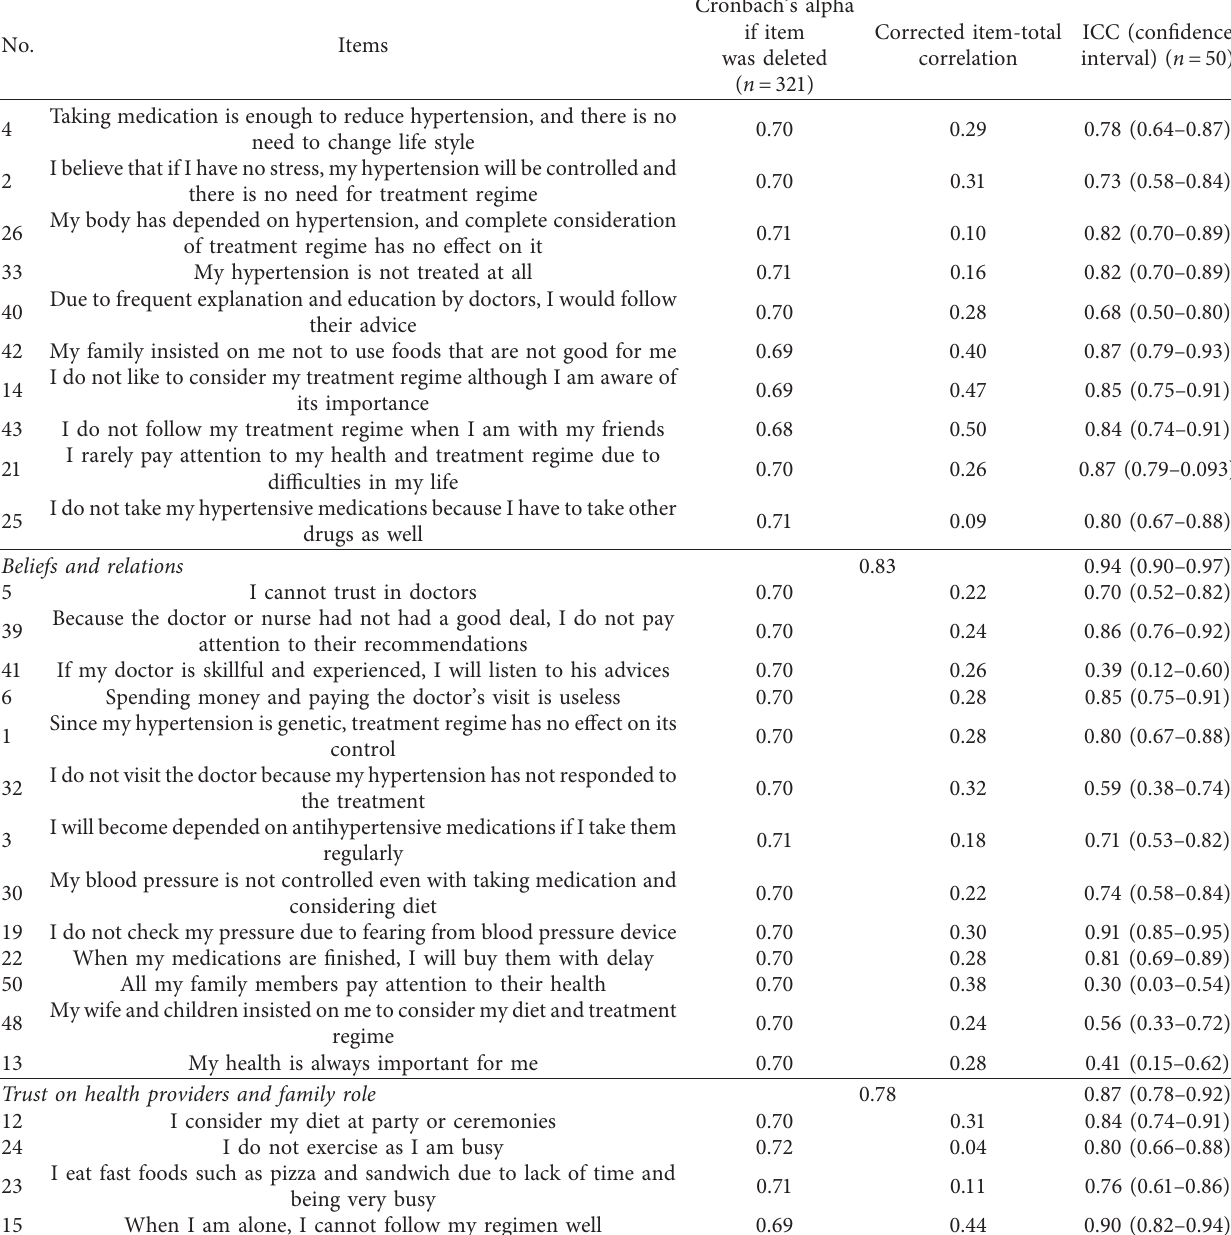
Table 7: Internal consistency of factors affecting the hypertensive treatment adherence scale and intraclass correlation.